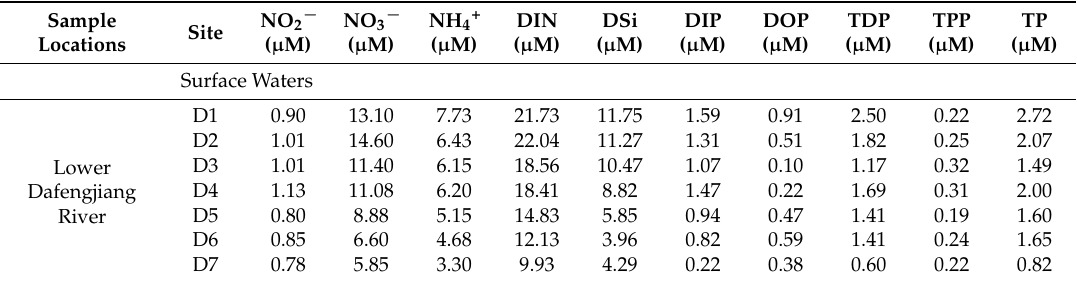
Table 2. Concentrations of NO 2 − , NO 3 − , NH 4+ , dissolved inorganic nitrogen (DIN), dissolved silicate (DSi), dissolved inorganic P (DIP), dissolved organic P (DOP), total dissolved phosphorus (TDP), total particulate phosphorus (TPP), and total phosphorus (TP) in surface and bottom waters of the Dafengjiang River estuary.